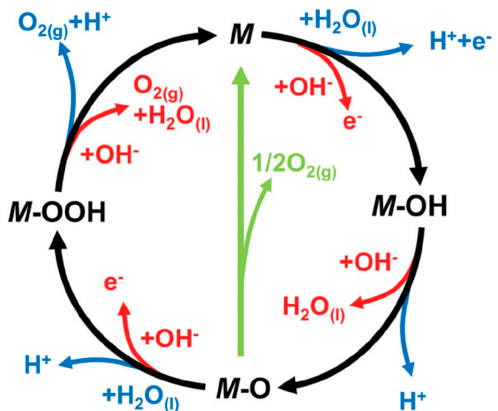
Figure 12. The oxygen evolution reaction (OER) mechanism in acid (blue line) and alkaline (red line) medium. Two reaction routes of oxygen evolution take place: (1) black line indicates that the process involves the formation of a peroxide (M–OOH) intermediate; (2) green line indicates that the direct reaction of two adjacent oxo (M–O) intermediates to produce molecular oxygen. Reproduced from [4], Copyright © Royal Society of Chemistry, 2017.